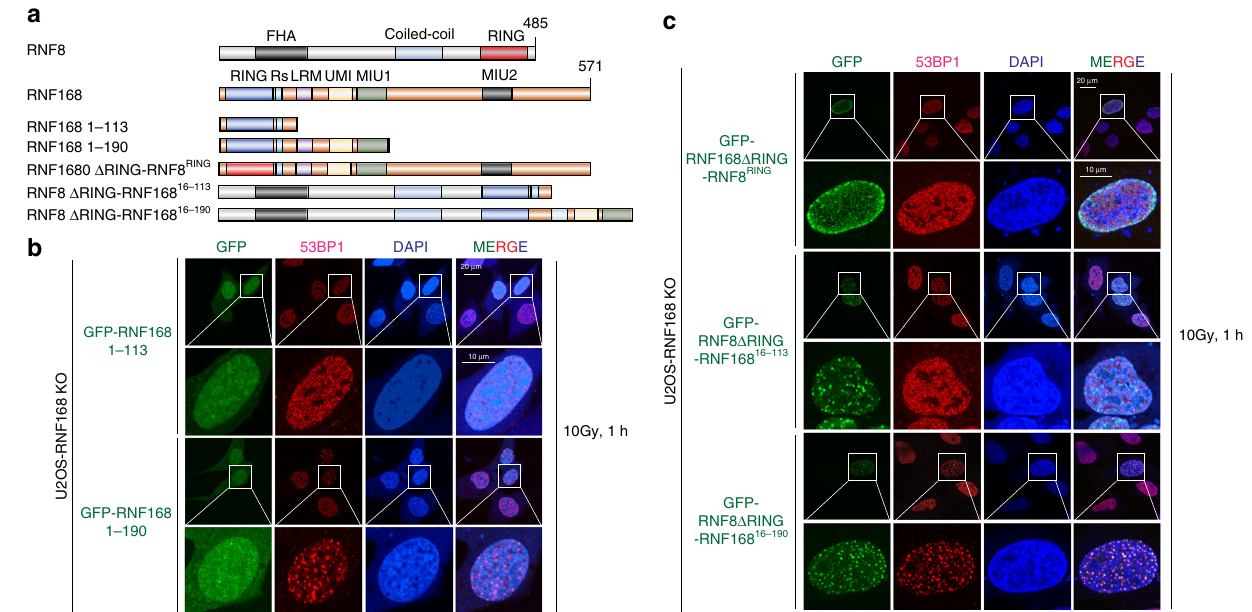
Fig. 6 UDM1 is required for RNF168-mediated 53BP1 recruitment. a Schematic illustration of RNF8 and RNF168 structural domain organization, RNF168 fragments, and chimeric proteins used as in b and c . FHA – forkhead-association domain; coiled-coil – coiled-coil domain; RING – ubiquitin E3 ligase RING domain; Rs-arginine anchor; LRM – LR motif; UMI – UIM-and MIU-related ubiquitin binding domain; MIU – motif interacting with ubiquitin. b – c Transient transfection of GFP-tagged RNF168 fragments and chimeric proteins in U2OS RNF168 KO cells. Cells were irradiated with 10 Gy and allowed to recover for 1 h followed by immuno fl uorescence analysis using 53BP1 antibody as indicated. Cells were counterstained with DAPI. Repeated at least two times independently with similar results. Source data are provided as Source Data fi